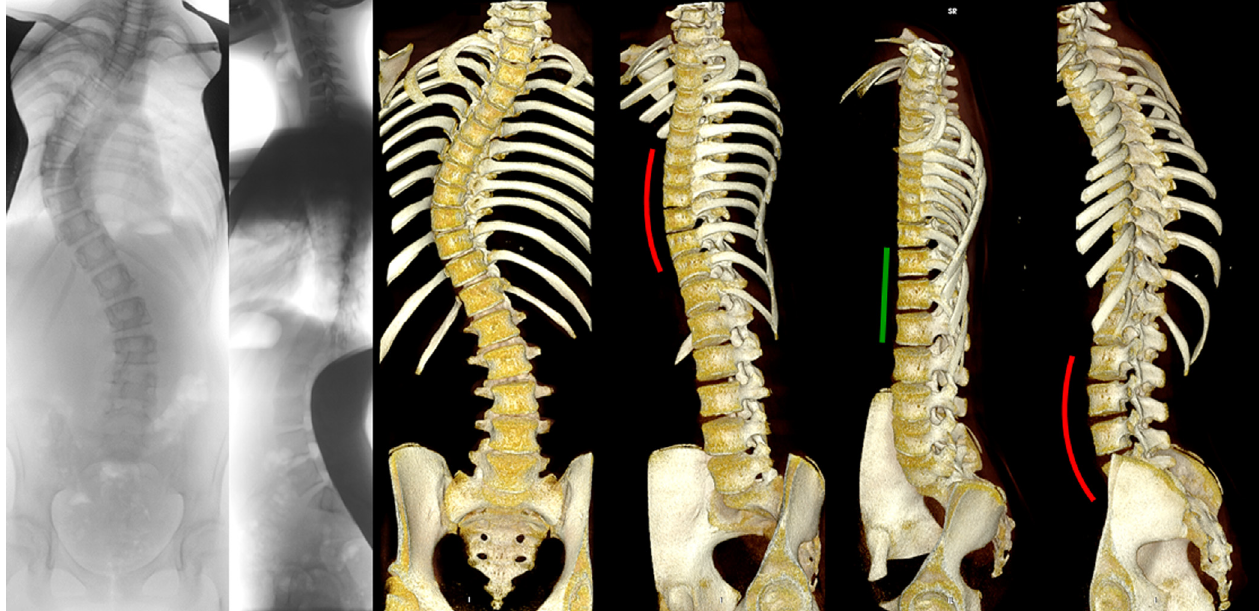
Fig 3. Posterior-anterior and lateral radiographs, and computed tomography reconstructions (OsiriX 64-bit; OsiriX Foundation, Los Angeles, CA, USA) are shown from an anterior and anterolateral view. In this representative 15-year-old patient with adolescent idiopathic scoliosis with a typical thoracic curve pattern, anterior overgrowth cannot be observed on the lateral radiography. The rotated lordoses of both thoracic and the (thoraco)lumbar curvatures, with a clearly longer anterior spinal column than posterior elements, are shown in red , and the straight junctional segment in-between in green from a true lateral view for these